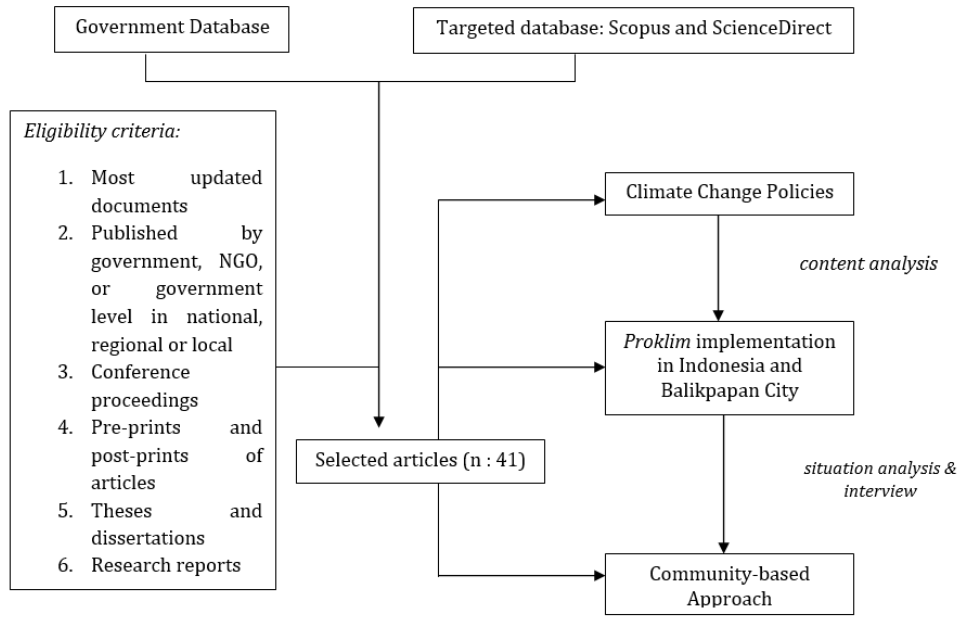
Figure 2. Research Flowchart (Source: authors).